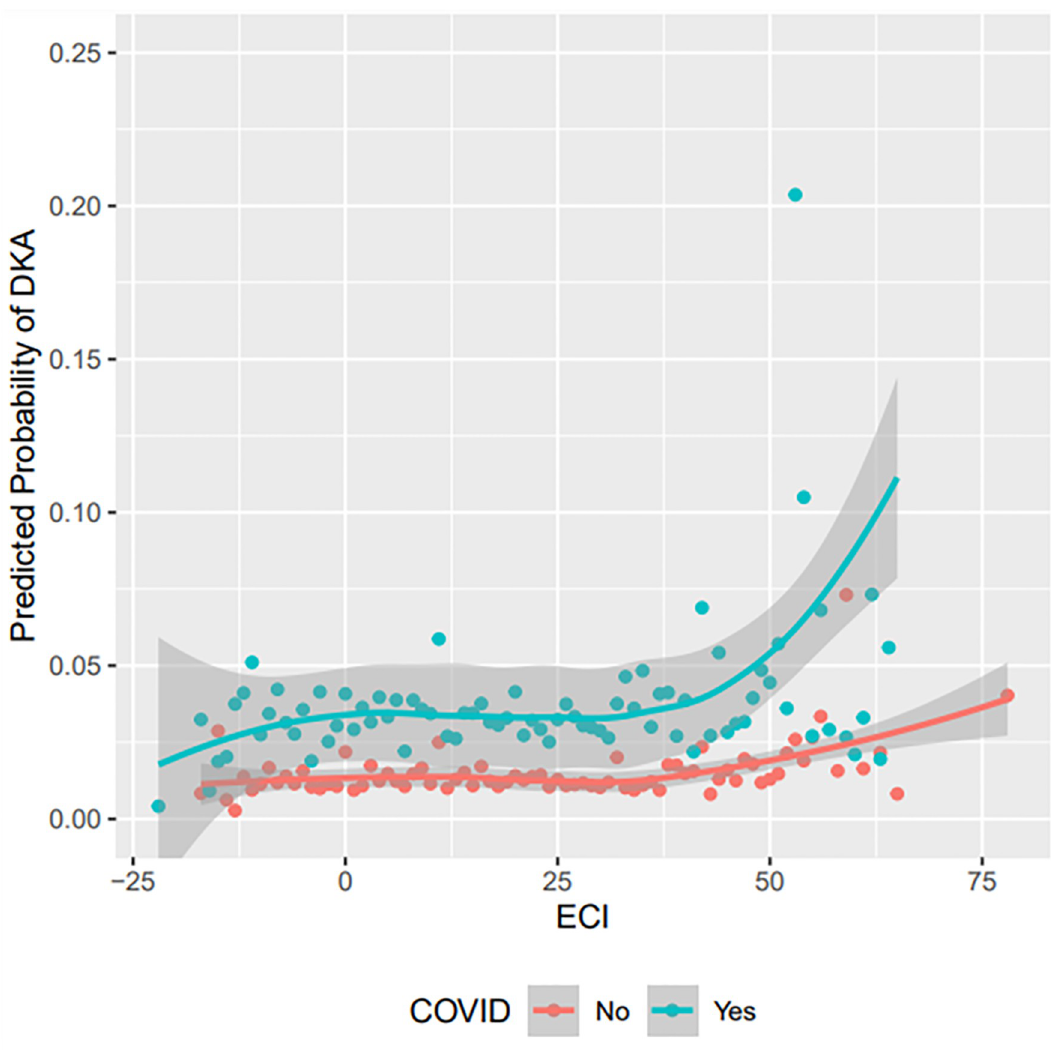
Fig 4. Predicted probability of DKA vs. ECI (by COVID-19 status) among patients with previous diagnosis of